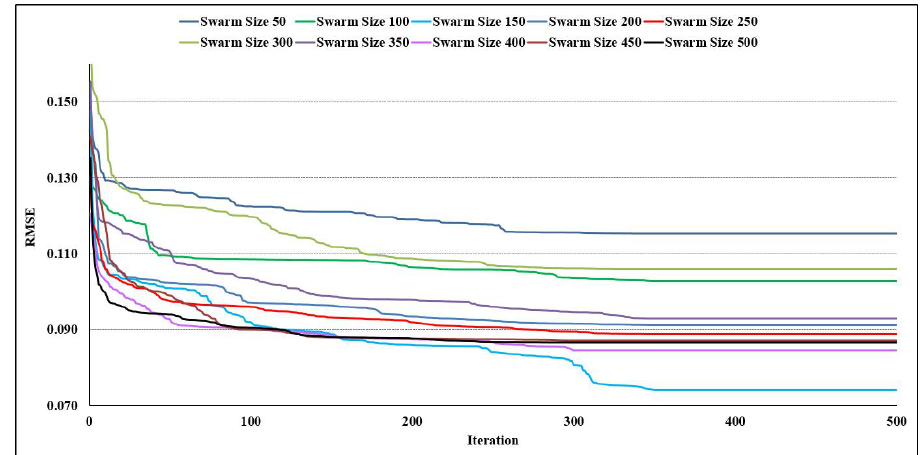
Figure 9. Ten PSO-ANN models and their RMSE results.